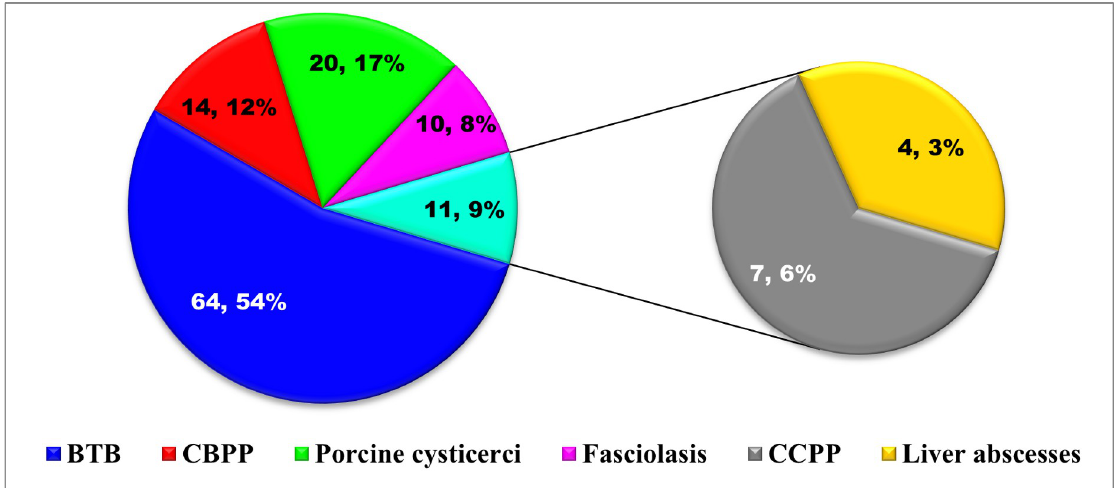
Fig 4. Frequency and proportions of major diseases/lesions (n = 119) found during PMI in four selected slaughterhouses surveyed in Southeast, Nigeria. BTB = bovine tuberculosis, CBPP = contagious bovine pleuro-pneumonia, CCPP = contagious caprine pleuro-